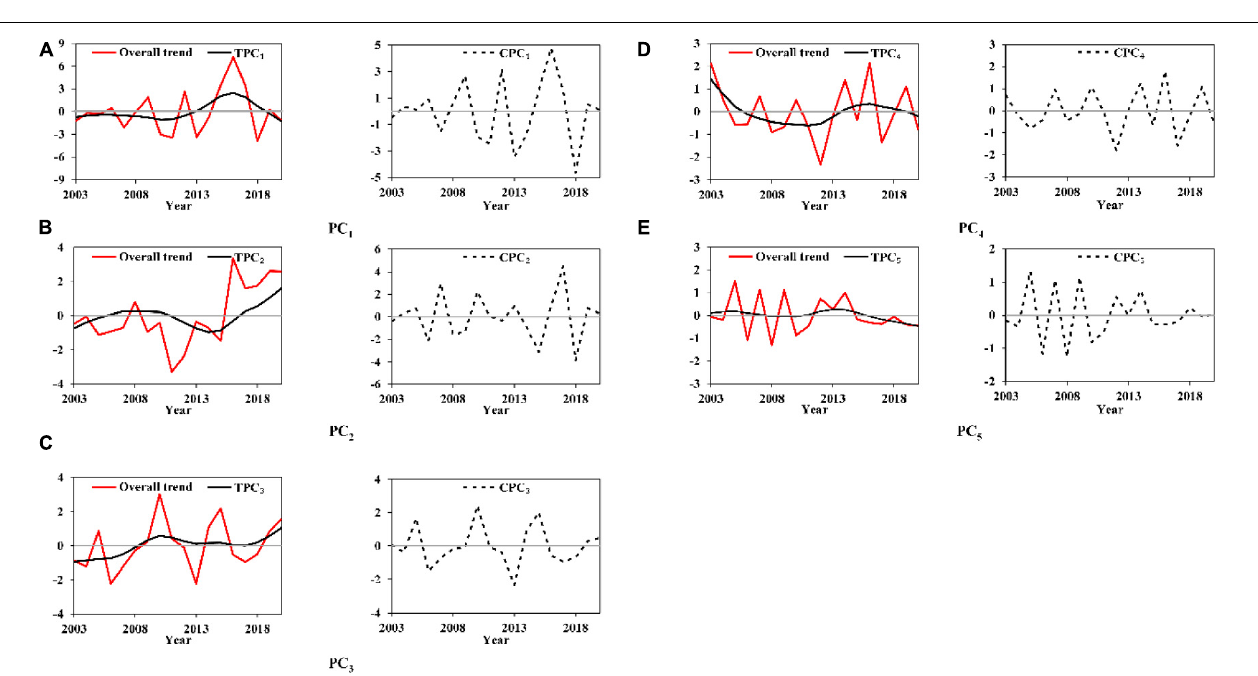
FIGURE 6 | Overall, annual and interannual trends (CPC i and TPC i ) of each principal component PC i for the sea surface temperature at the spawning and feeding ground to Dosidicus gigas. (Panels A–E indicate the Hodrick-Prescott filter analysis results of PC 1 -PC 5 ).